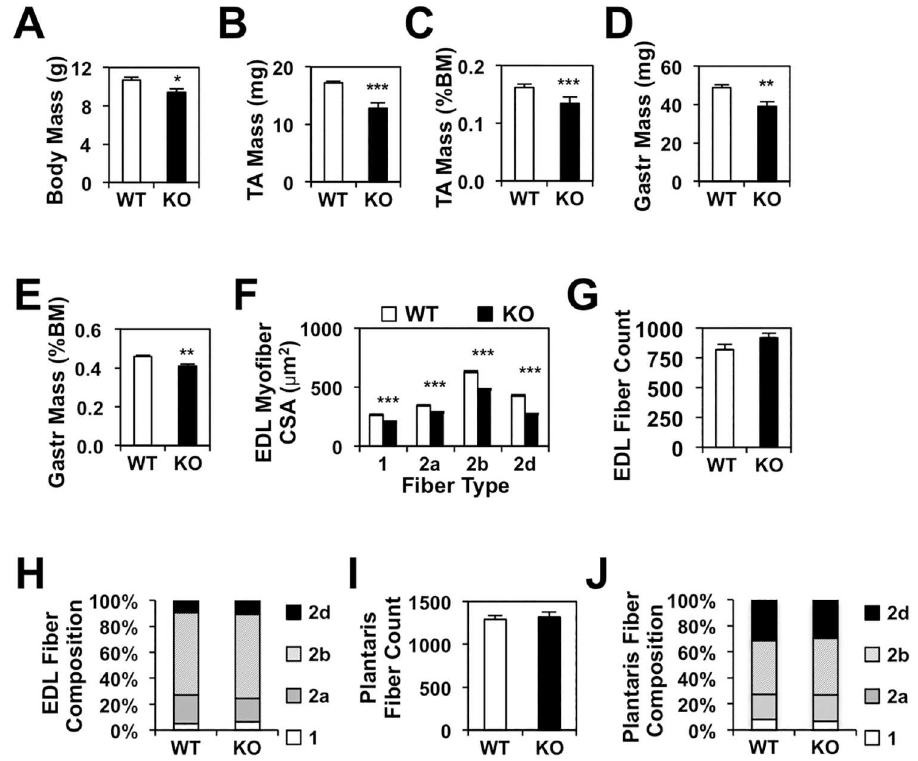
Fig 1. Nur77 deficiency reduces myofiber size by 3 weeks of age. (A-E) Body and muscle mass in 3-week-old global Nur77 -/- mice. N = 10–14.(F-H) Mean cross-sectional area (CSA), mean fiber count, and fiber composition of EDL muscle in wildtypeand Nur77 -/- mice. N = 6. (I-J) Mean fiber count and fiber composition of plantarismuscle (N = 6–7). * P < 0.05, ** P < 0.01, *** P < 0.001. WT—wildtype, KO—knockout, TA—tibialis anterior, Gastr—gastrocnemius,BM—body mass, EDL—extensor digitorumlongus.